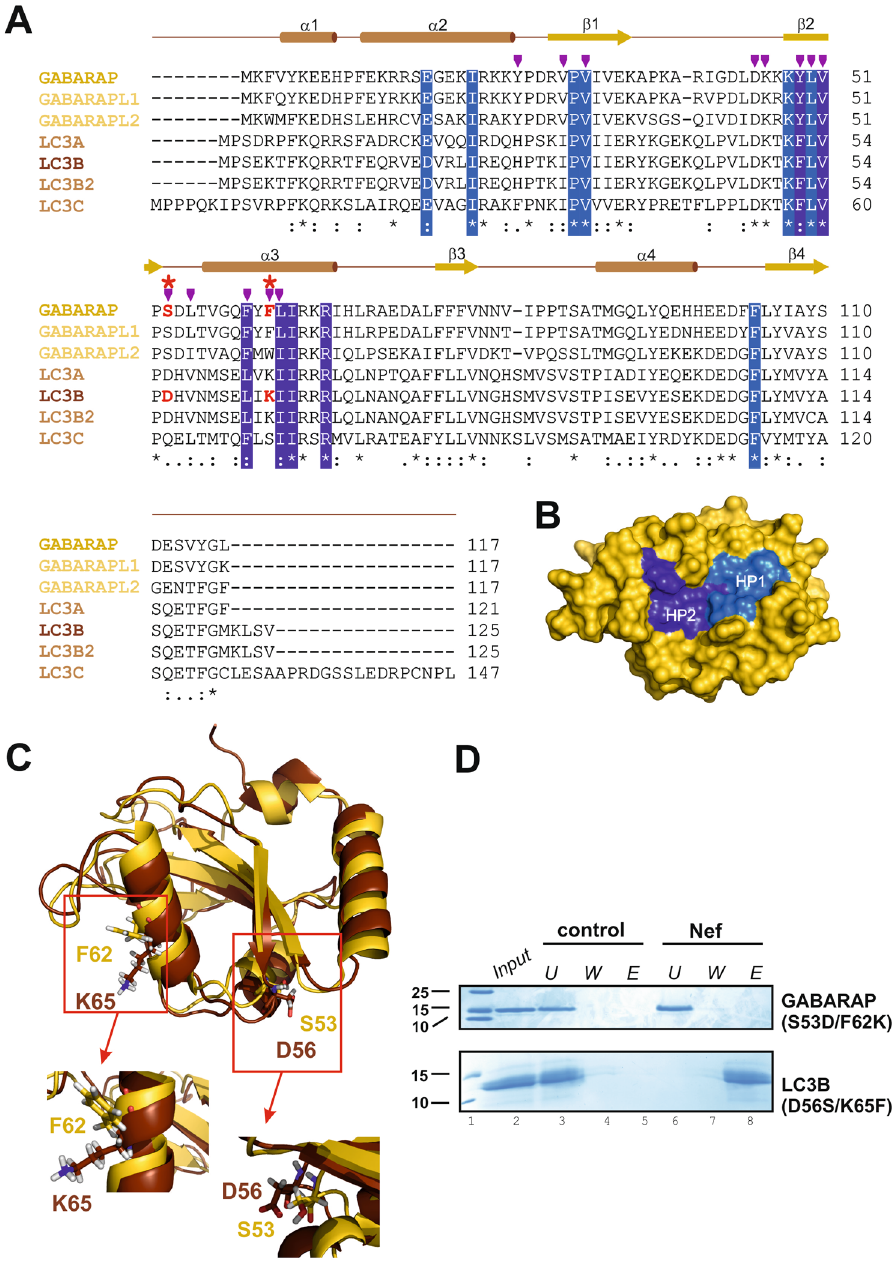
Figure 3. GABARAP residues S53 and S62 are essential for Nef binding. ( A ) Human ATG8s sequence alignment indicates putative key residues for Nef binding specificity. Protein names of ATG8s showing Nef binding during pull-down and immunoprecipitation analysis are given in different shades of yellow, and include all members of the GABARAP subfamily. Protein names of LC3B and of the other LC3s are given in different shades of brown. Purple arrows indicate residues of GABARAP showing chemical shift changes higher than 0.05 ppm (see Fig. 2C) upon Nef titration. Residues forming HP1 and HP2 are shaded in light and dark blue, respectively. Red asterisks highlight putative key positions for determining Nef-binding specificity. The corresponding amino acids found in GABARAP and LC3B at these positions are highlighted in red. ( B ) Visualization of HP1 and HP2 on the surface of the GABARAP structure [PDB ID: 1KOT]. ( C ) Structural overlay of GABARAP and LC3B with the putative key residues necessary for Nef-binding highlighted. Cartoon representations of GABARAP (yellow) and LC3B (brown) [PDB ID: 1V49] showing their regular secondary structure elements demonstrate that S53 and F62 of GABARAP as well as the corresponding D56 and K65 of LC3B are surface exposed, and therefore are available for ligand binding. Details highlight the side chain orientations of the key residues, for this the structures have been rotated appropriately. ( D ) Nef-conjugated or free Sepharose beads (control) were incubated with GABARAP(S53D/F62K) or LC3B(D56S/K65F) mutants. The input, the unbound material of the flow through (U),the wash (W) fractions and the eluate (E) fractions were subjected to SDS-PAGE and visualized by CBB staining. Full-length gels are presented in Supplementary Fig.